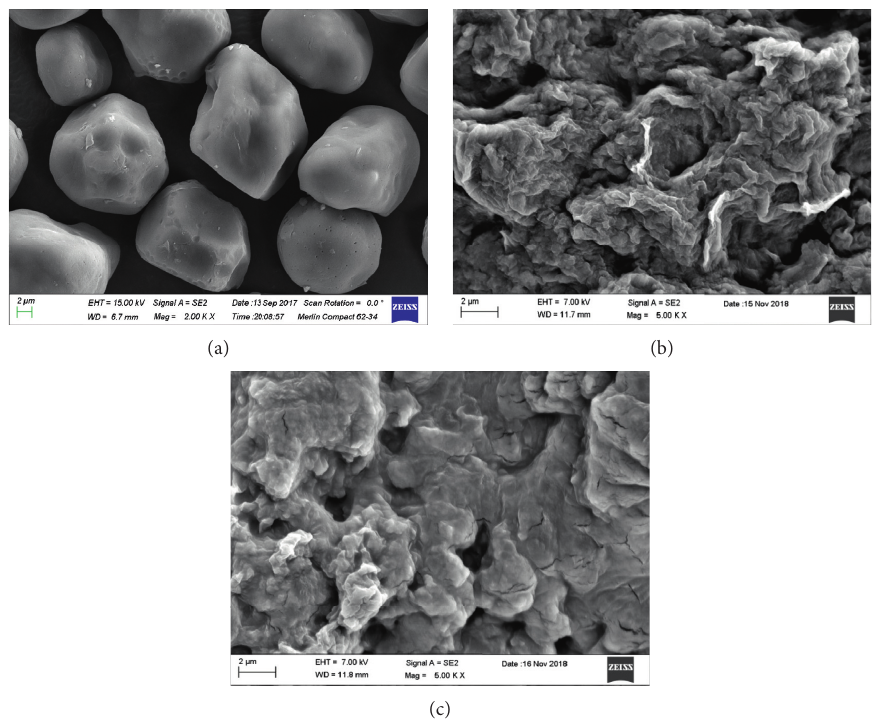
Figure 4: Grain morphology of sorghum starch and resistant starch: (a) native starch; (b) unfermented RS; (c) fermented RS. Table 6: Acid production of sorghum starch and resistant starch in simulated human intestine.